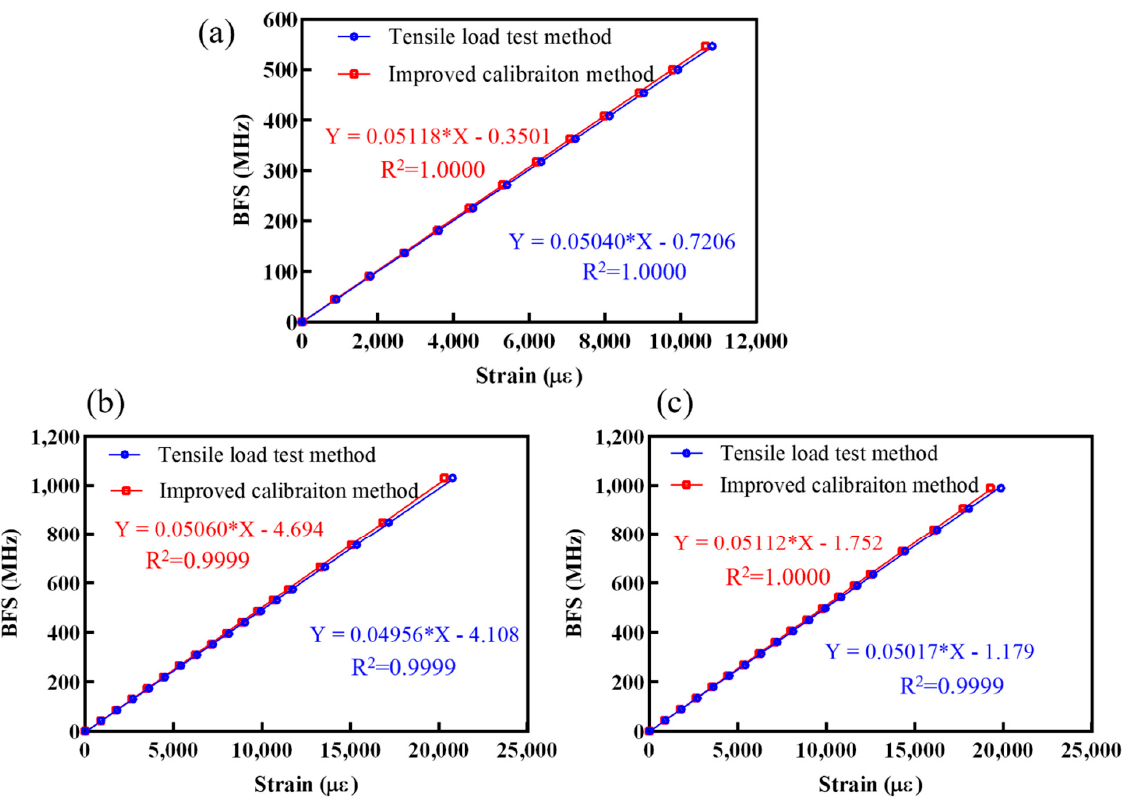
Figure 10. Calibration results for ( a ) sensing cable A, ( b ) sensing cable B, and ( c ) sensing cable C.